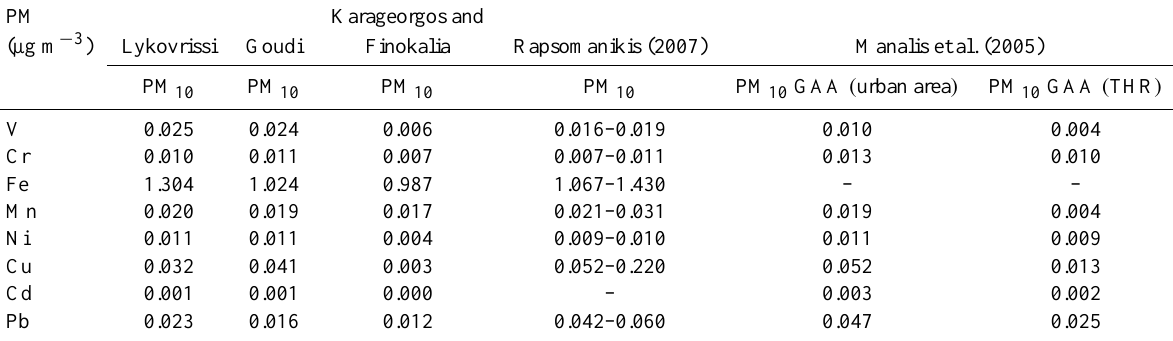
Table 3. Annual mean concentrations of metals (µgm − 3 ) measured at Lykovrissi (PM 1 and PM 10 ) and Goudi (PM 10 ) from September 2005 to August 2006 and comparison with literature